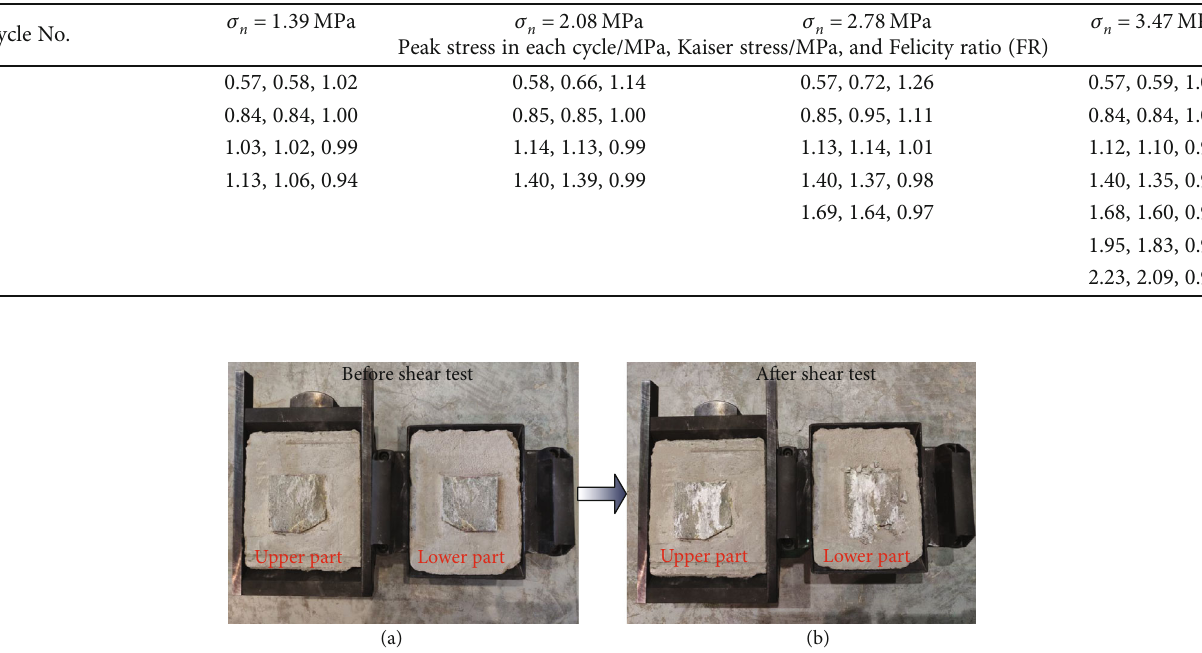
Figure 9: Upper and lower parts of jointed skarn specimens: (a) before shear test and (b) after shear